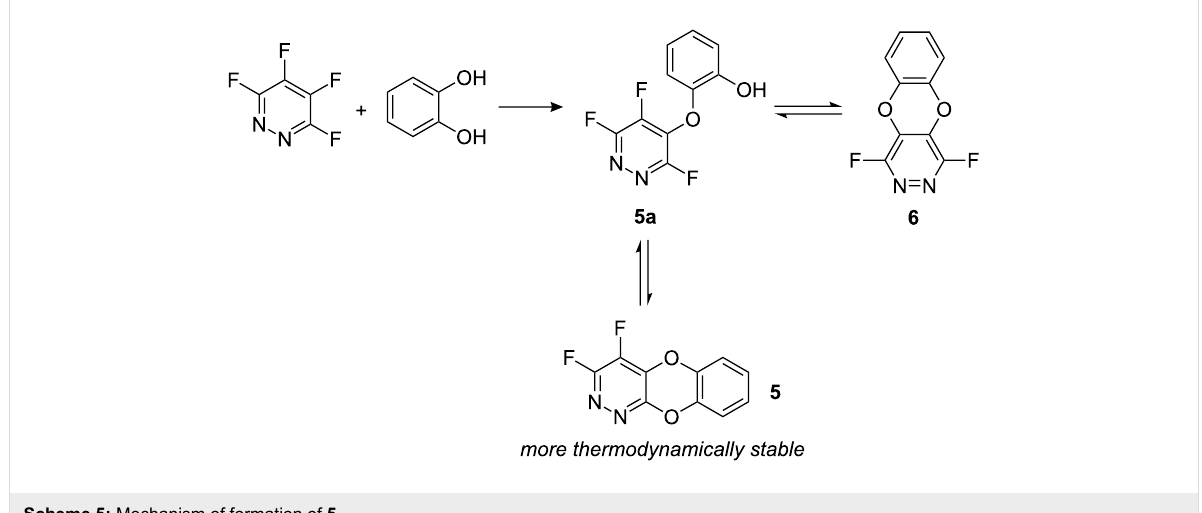
Scheme 5: Mechanism of formation of 5 .